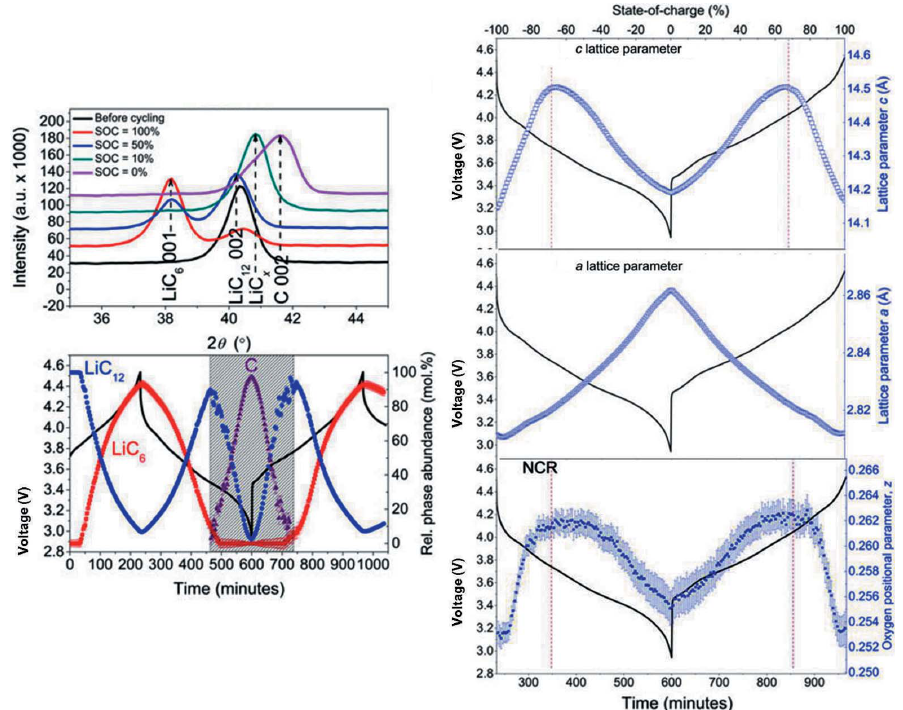
Figure 9 Phase evolution of the (left) carbon and (right) Li(Ni,Co,Al)O 2 electrodes within an 18650-type commercial battery obtained using operando neutron powder diffraction on WOMBAT. Also shown are the associated voltage profile and extracted oxygen positional parameter of the Li(Ni,Co,Al)O 2 structure. Adapted from Pang et al.